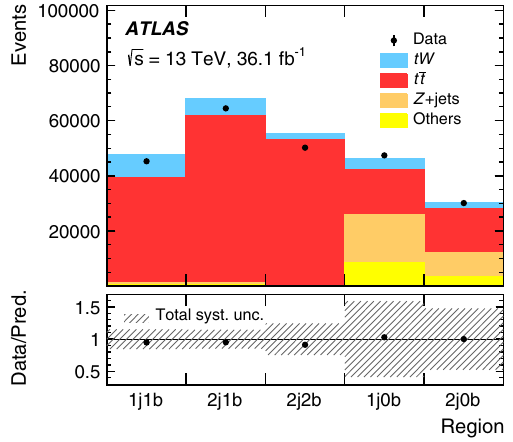
Fig. 2 Expected event yields for signal and backgrounds with their total systematic uncertainty (discussed in Sect. 8) and the number of observed events in data shown in the signal region (labelled 1j1b) and the four additional regions (labelled 2j1b, 2j2b, 1j0b and 2j0b, based on the number of selected jets and b -tagged jets). “Others” includes diboson and fake-lepton backgrounds. The signal and backgrounds are normalised to their theoretical predictions, and the error bands in the lower panel represent the total systematic uncertainties which are used inthisanalysis.Theupperpanelgivestheyieldsinnumberofeventsper bin, while the lower panel gives the ratios of the numbers of observed